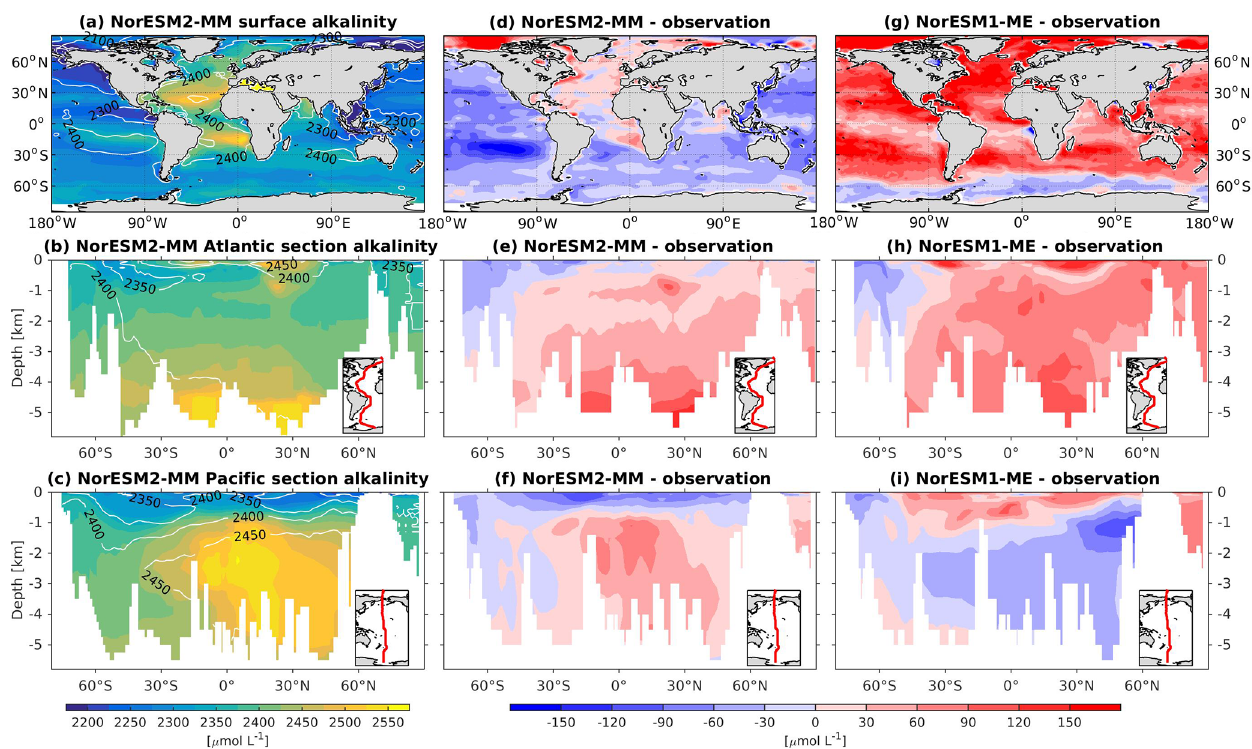
Figure 17. Climatological alkalinity values at the (a) surface and across the vertical sections of (b) the Atlantic and (c) Pacific in NorESM2- MM (colour shadings) and from observations (contour lines). Differences between NorESM2-MM (or NorESM1-ME) and observations are shown in panels (d) – (i)